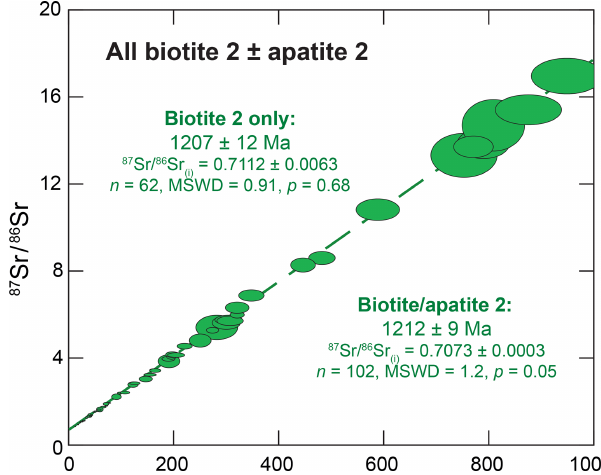
Figure 10. Combined isochron of biotite 2 analyses from all four samples in the Tropicana gold mine, computed with and without apatite